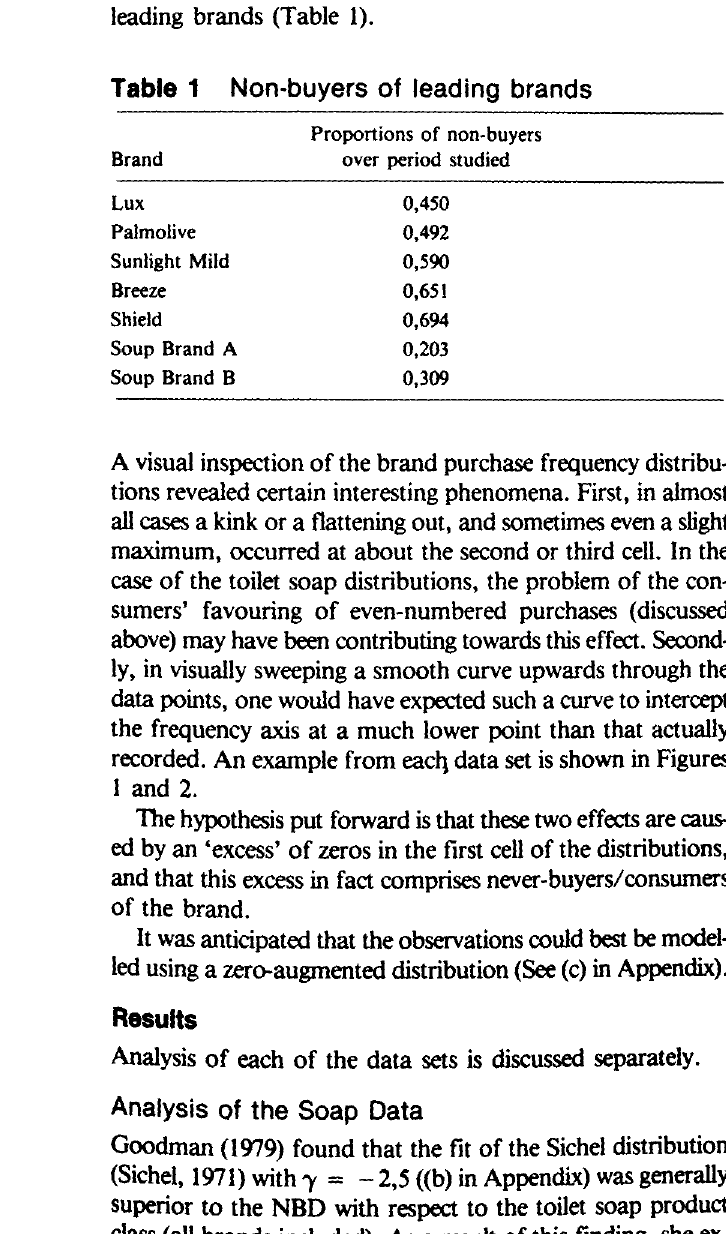
Figure 2 Observed frequency distribution for combined brands A and B of soup - first four months (N = 614)